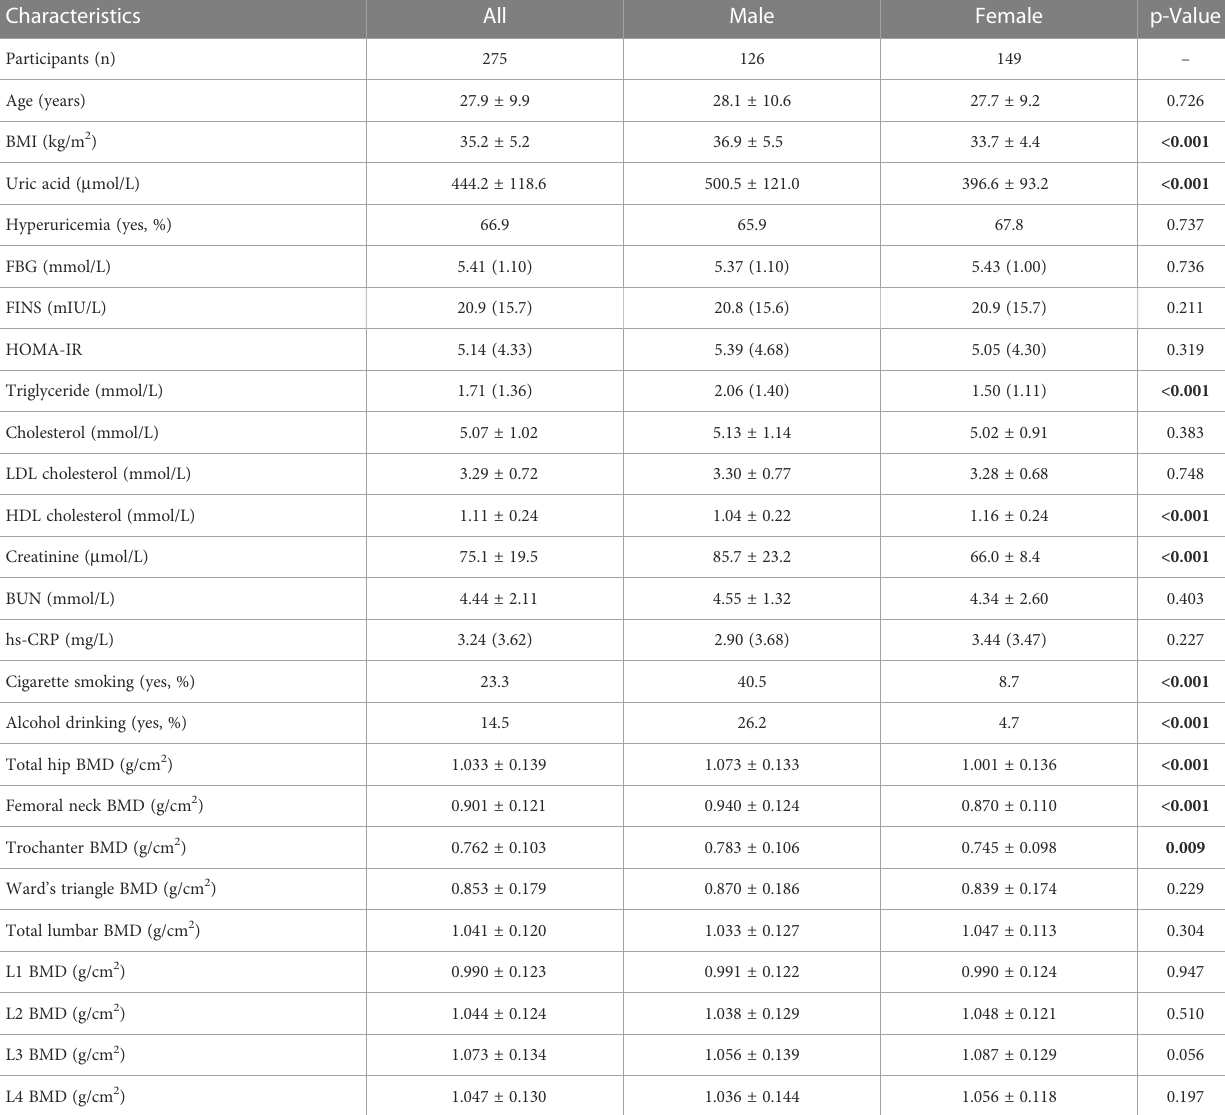
TABLE 1 The main characteristics of the obese population.